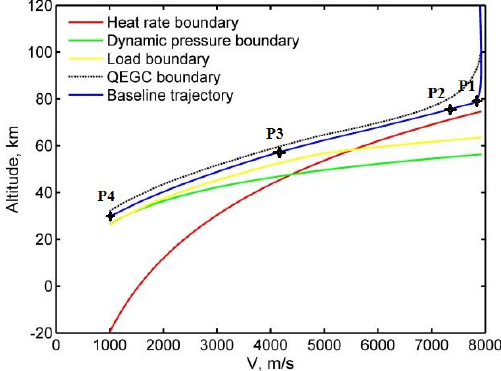
Figure 5. Reference baseline trajectory in the corridor of constraints.